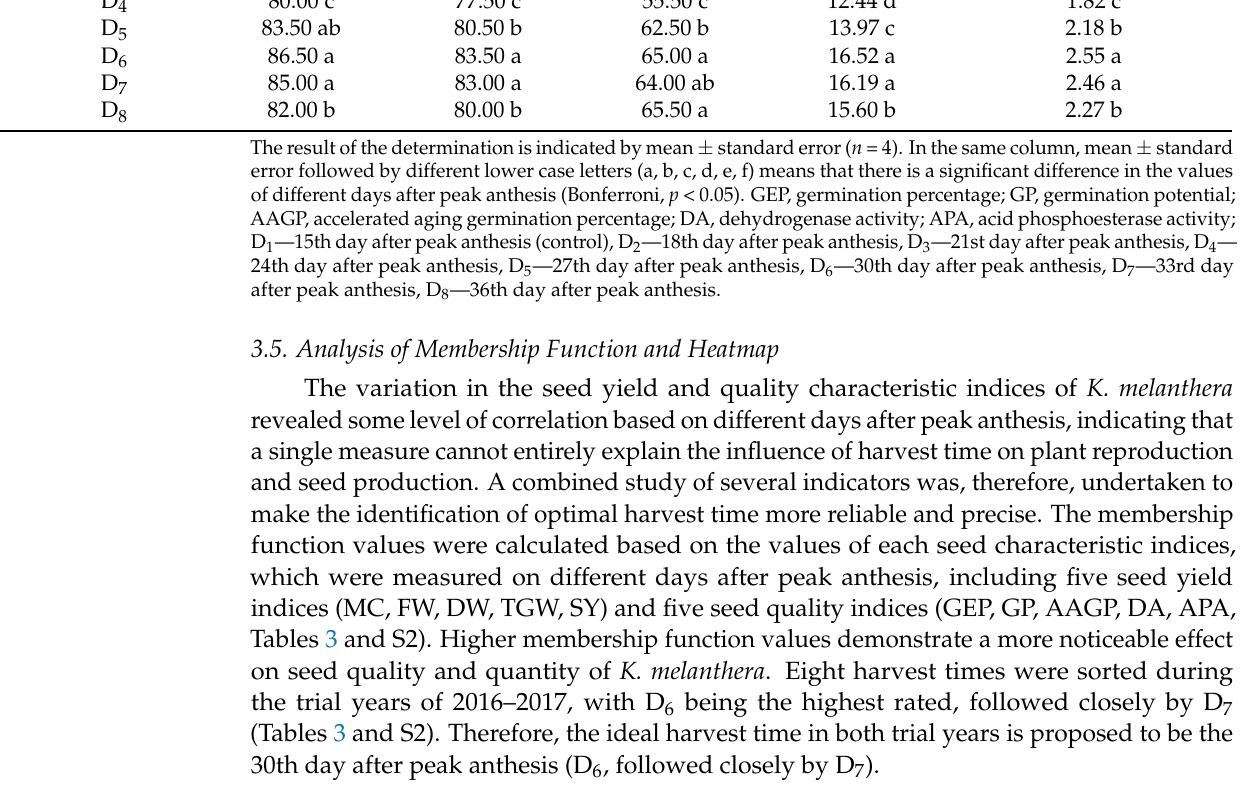
Table 3. The influences of multi-indicator analysis of membership functions on K. melanthera on different days after peak anthesis during the 2016 trial